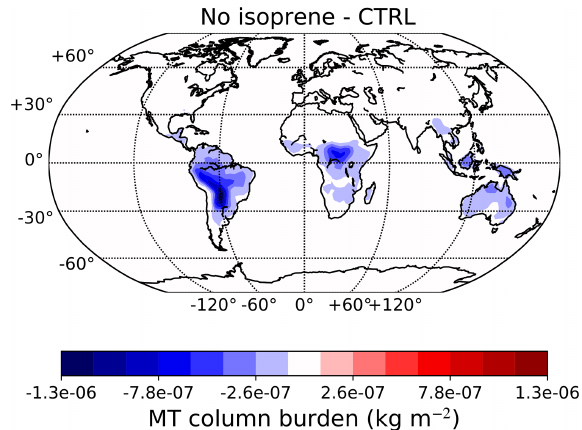
Figure 10. Map of the difference in the average MT column burden between the No isoprene and CTRL simulations for